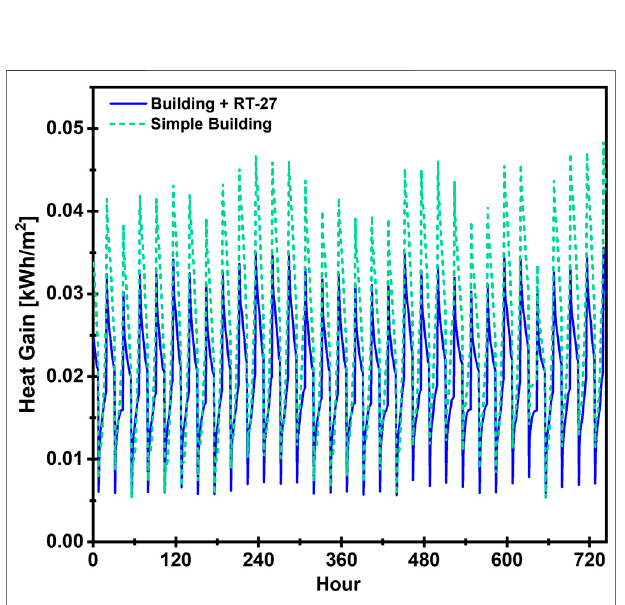
FIGURE 6 | Heat gain for simple building and building fi lled with RT-27.